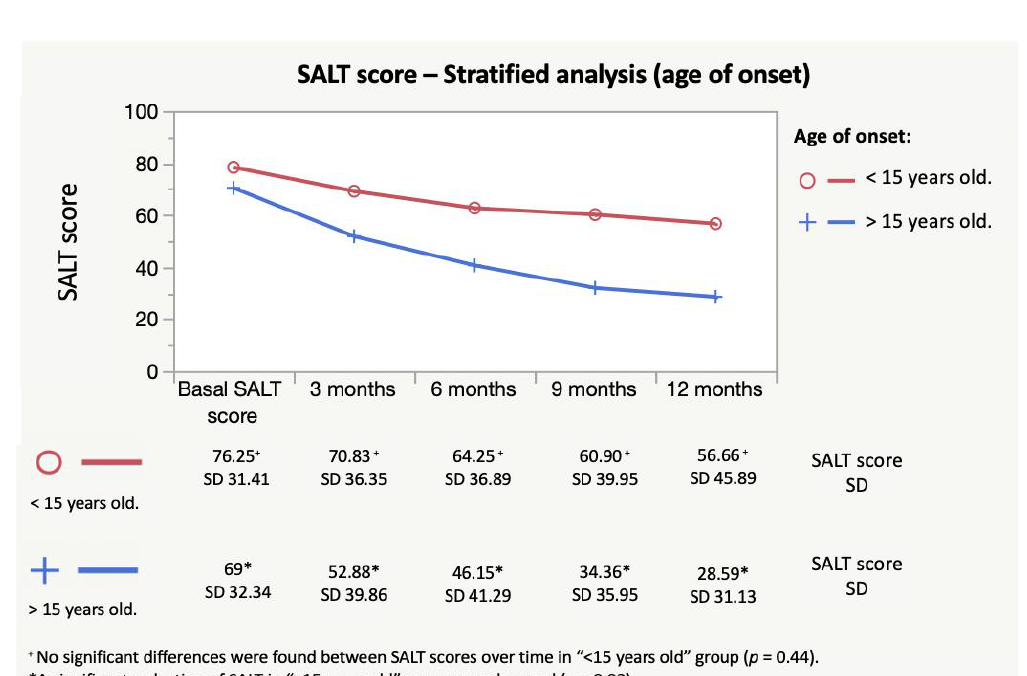
Figure 2. Evolution of SALT scores after the treatment with dexamethasone; stratified analysis by age of onset. Stratified analysis showed that no significant decrease of SALT was found over time in “early onset” group, whereas a significant decrease of SALT scores was present in “late onset” group. No differences were found between both groups in main basal characteristics (Table 2).